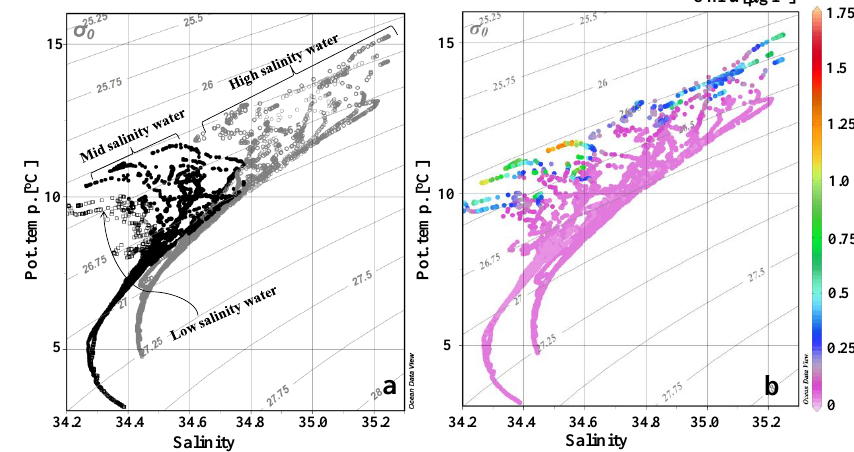
Fig. 2. (a) T-S diagram over the Chatham Rise, east of New Zealand ( ◦ high salinity (S > 34.8) water; • mid-salinity (34.5 < S < 34.8) water; (cid:3) low salinity (S < 34.5) waters). The isopycnal lines are also shown; (b) Regional distribution of Chl- a plotted on the T-S diagram. Fig.3